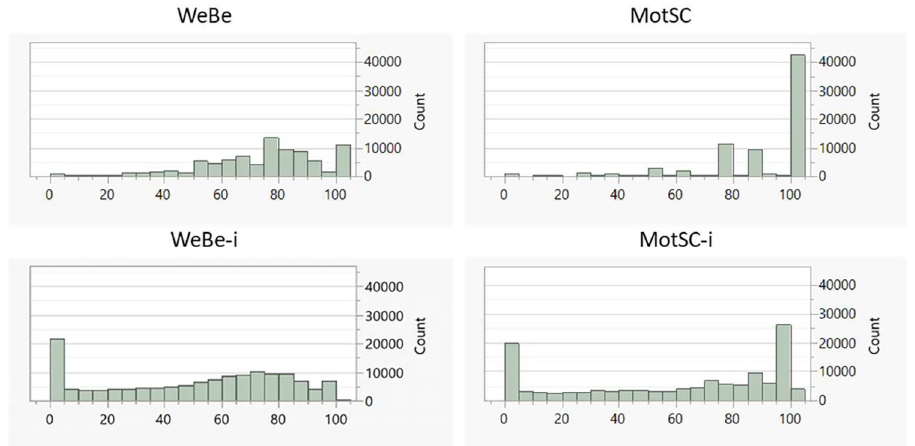
Fig 1. Distribution of averaged wellbeing data, WeBe, and motivation and self-confidence data, MotSC, (top) and the corresponding digital biomarkers, WeBe-i and MotSC-i (bottom). week long, with missing data (Fig 2, black diamonds in WeBe-i and MotSC-i graphs) and alco- hol was detected 10/13 days (red squares). This is captured in the WeBe-i and MotSc-i time series where the detected alcohol (red squares) in the beginning and omitted breathalyzer test (black diamonds) during exacerbation events are captured in the decreasing index values (Fig 2). The individual and qualitative aspect of questionnaire data is also evident when comparing the timeseries of the 3 patients. Patient A and B have similar average clinical course based on detected alcohol and breathalyzer test compliance (Fig 2. AMI) but they drastically differ in both WeBe (80/47) and MotSc (83/11) levels, i.e. there is no direct linear relationship with